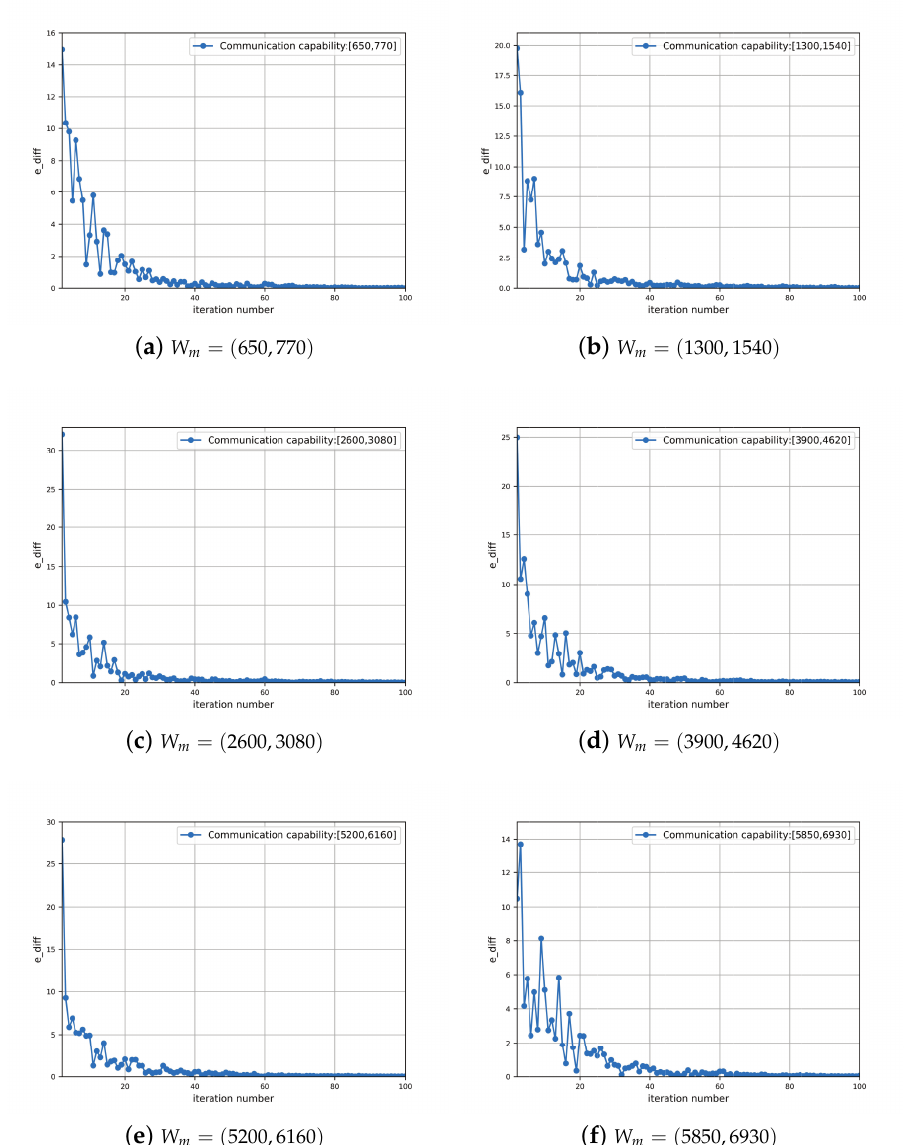
Figure 10. The e _ dif f of the proposed algorithm under different communication